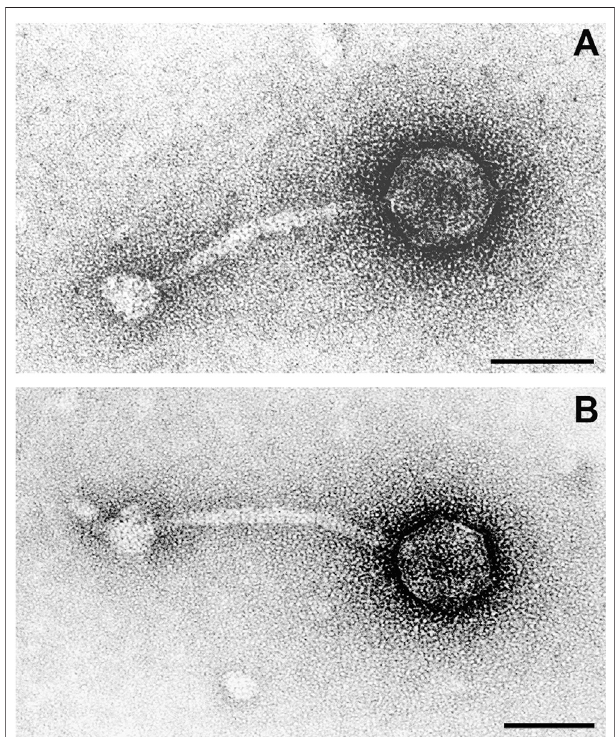
FIGURE 7 | Transmission electron microscope image of two phage particles resulting from Mitomycin C treatment of bacterial strain RGB- 095930. In particle (A) details of the icosahedral head, in particle (B) details of the tail and baseplate are more clearly depicted. Negative contrast preparation, contrasted with uranyl acetate. Bars (cid:1) 50